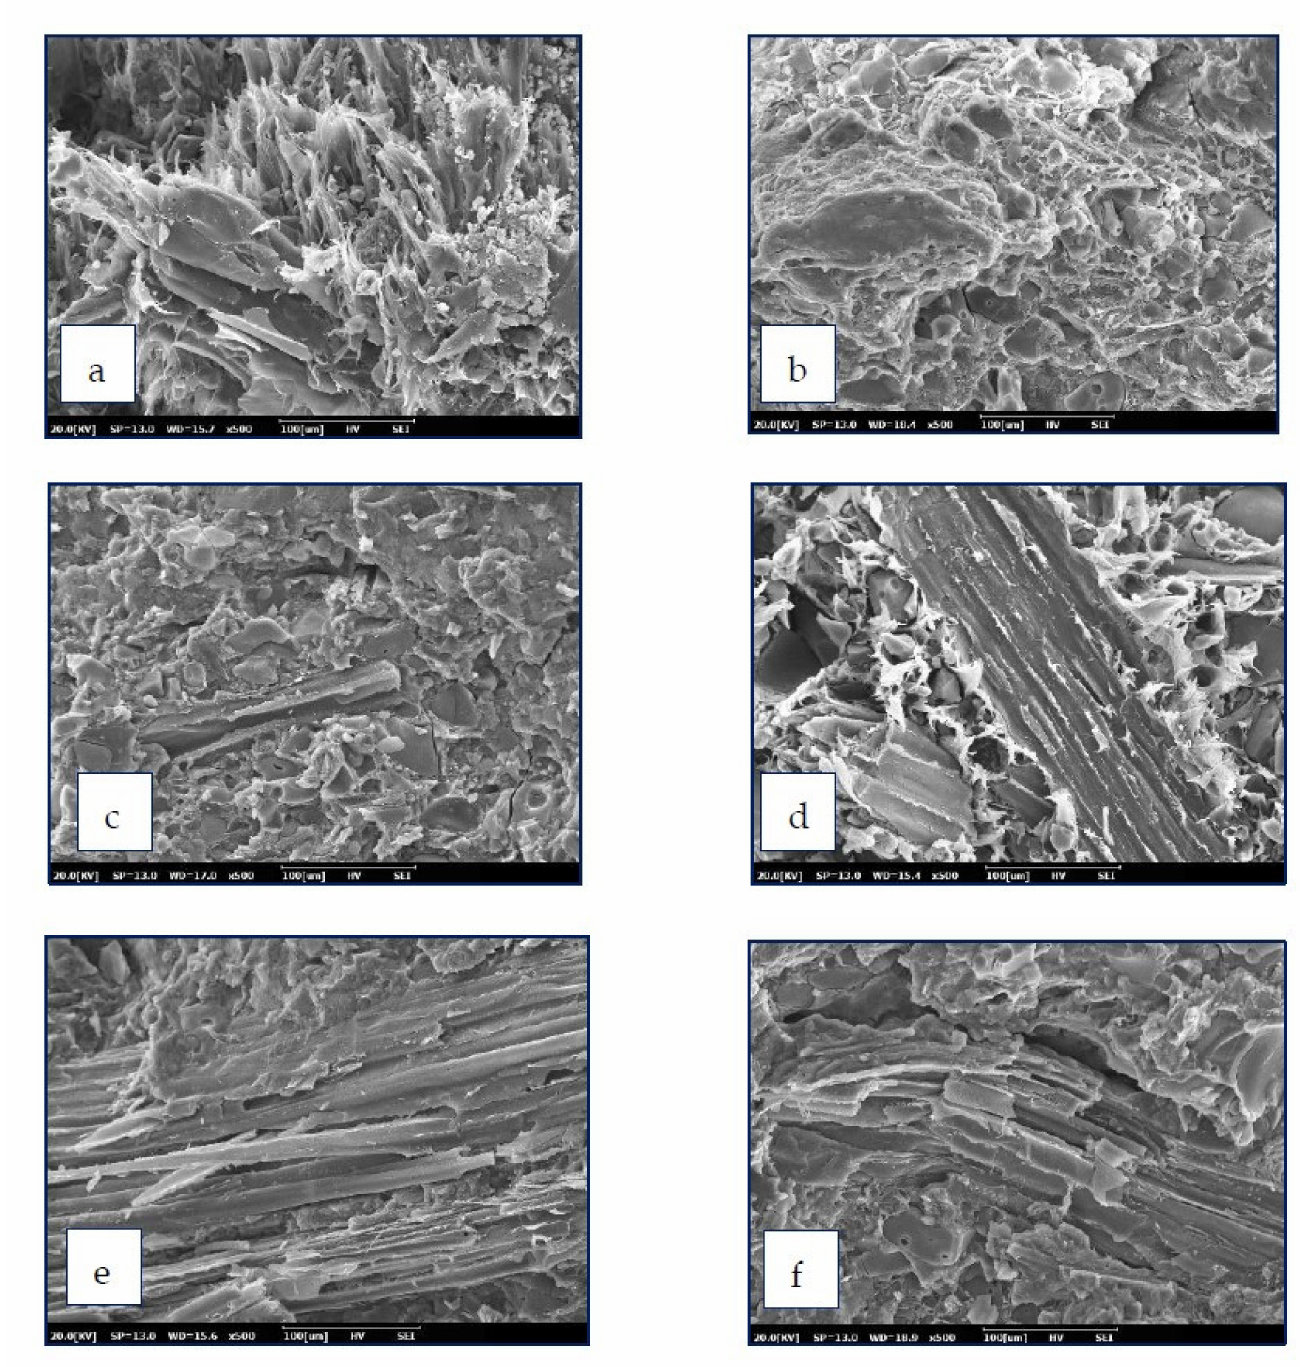
Figure 11. SEM micrograph of PBS composites: ( a ) PBS70/L30, ( b ) PBS70/ML30, ( c ) PBS60/L30/KCF10, ( d ) PBS60/ ML30/KCF10, ( e ) PBS50/L30/KCF20, and ( f )